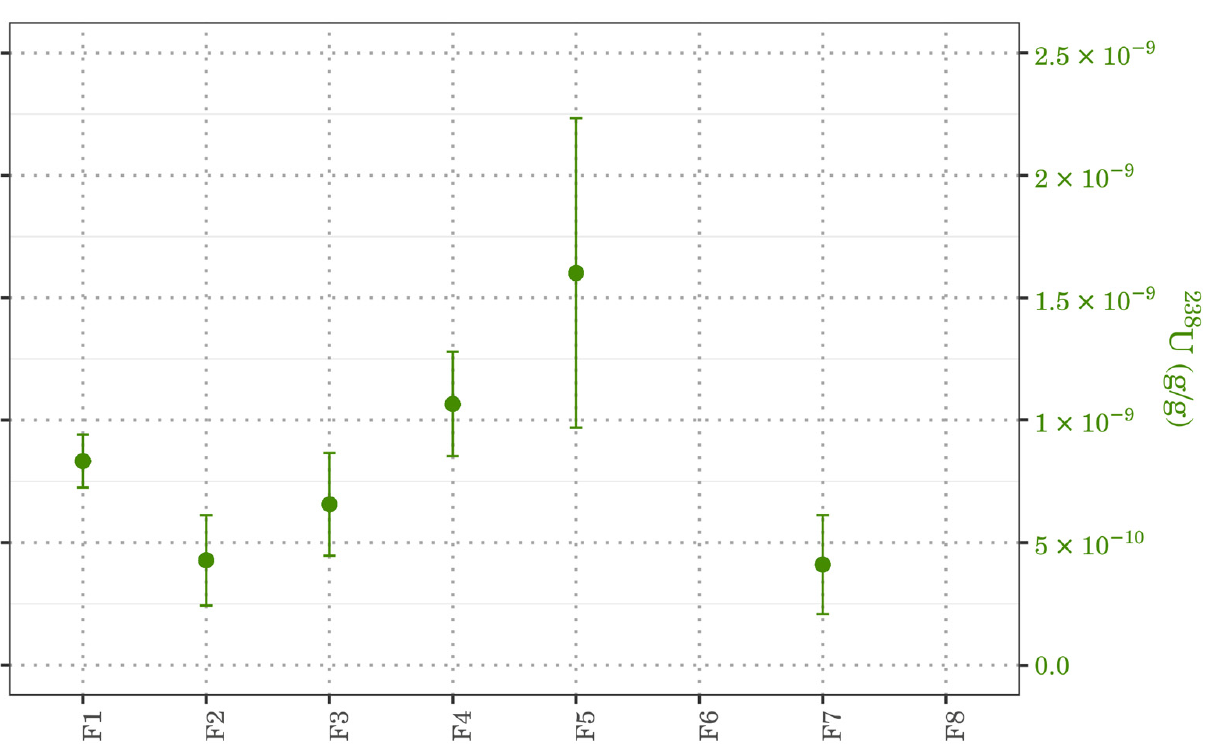
Figure 3. 238 U concentration measured in river water samples. Values below the detection limit are not shown.